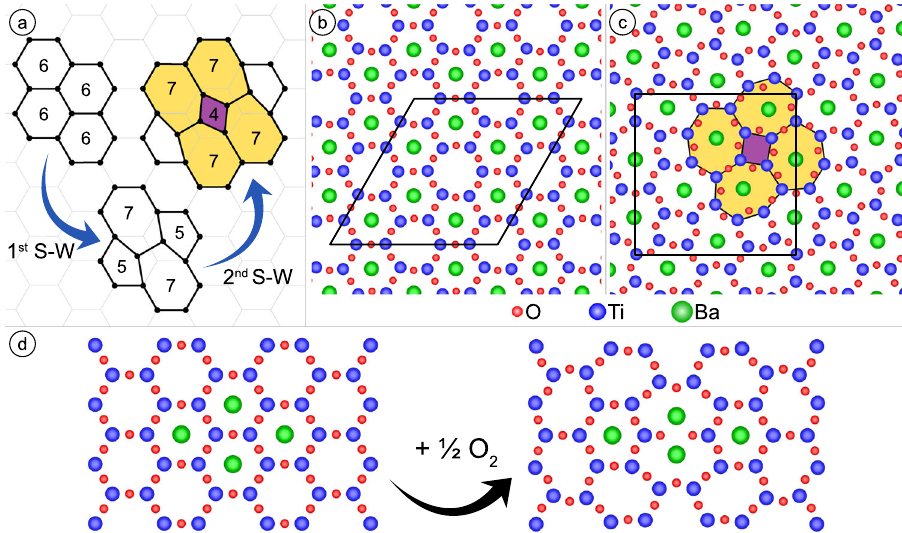
Fig. 4 | Stone – Wales transformation converting honeycomb structure into square-triangle tiling and rhombus formation by incorporation of additional oxygen.a Transitionfromahoneycomblattice bysubsequentStone – Wales(S – W) transformationsintoastructureoffour-andseven-memberrings. b Comparisonof the DFT relaxed structures of the Ba-decorated Ti 2 O 3 honeycomb structure and c the Ba-Ti-O sigma-phase approximant on Pt(111). The DFT calculations were